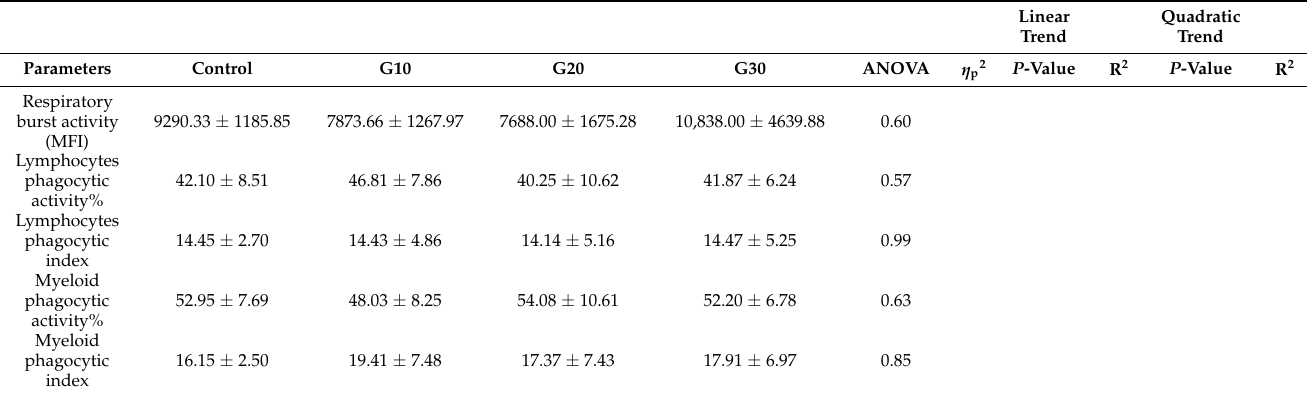
Table 7. Immunological parameters of Eurasian perch provided feed supplemented with garlic